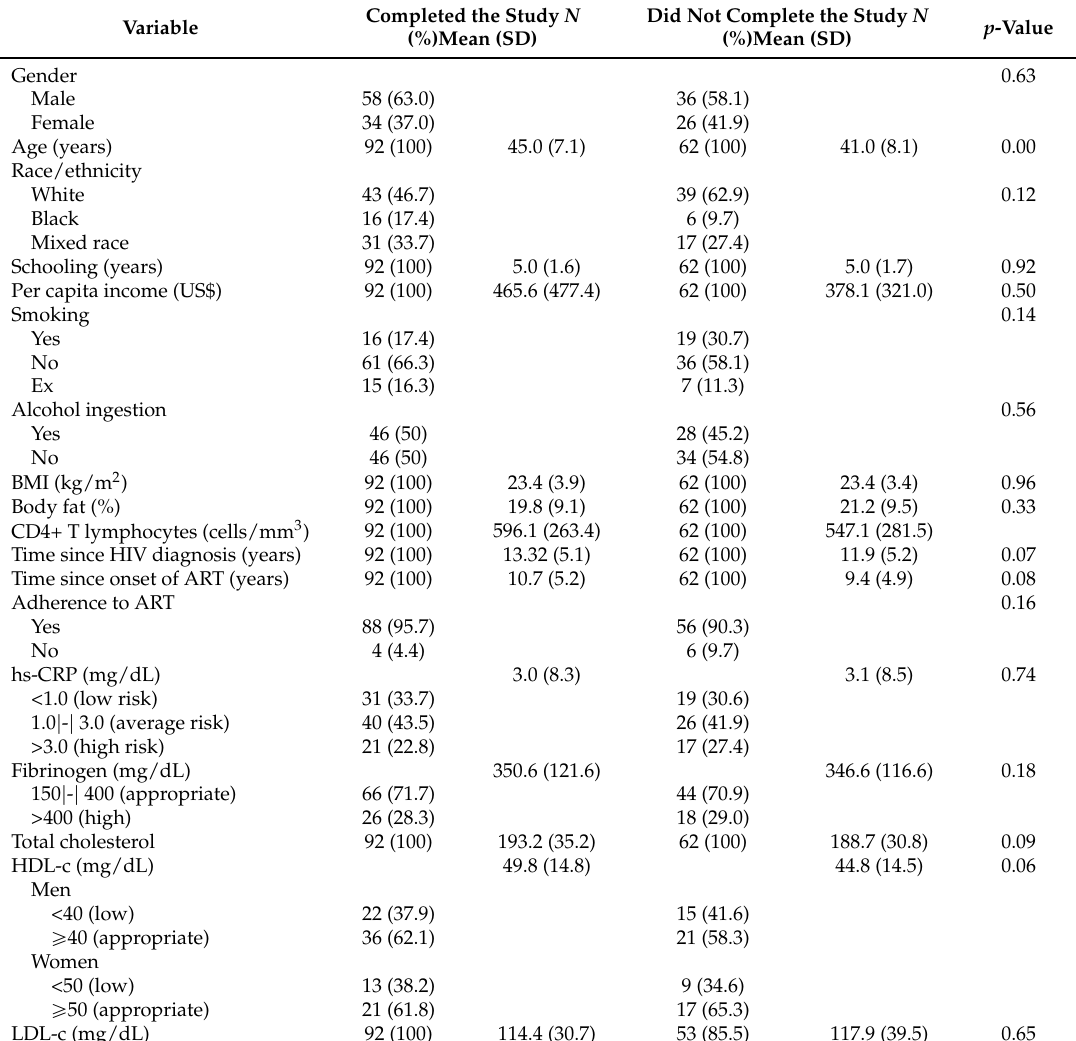
Table 1. Comparison of the characteristics of individuals with HIV/AIDS undergoing antiretroviral therapy who completed the study ( n = 92) and those who did not ( n =